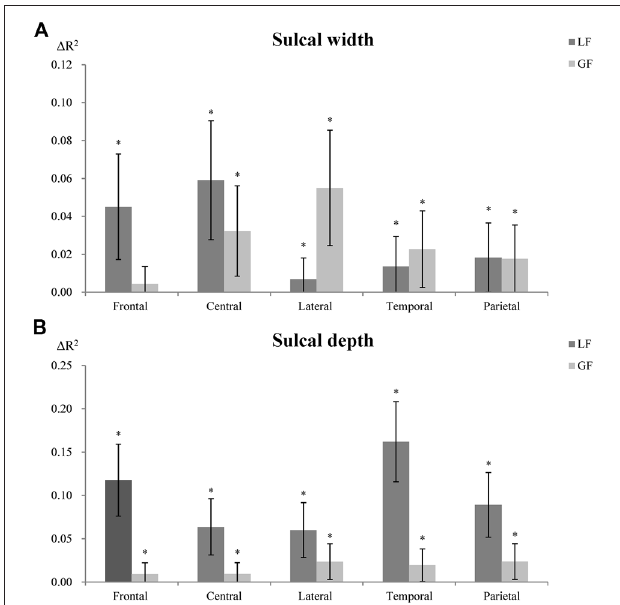
FIGURE 5 | Contribution of LF and GF to sulcal width (A) and depth (B) . Local factors (LF); global factors (GF). The R-squared changes ( ∆ R 2 ) indicate changes of explanatory power between models with and without LF or GF (proportion of variability of the sulcal measures explained by LF or GF). ∗ Indicates significant association ( p < 0.01) between LF or GF and sulcal width or depth. Error bar shows 95% confidence interval, which indicates significant differences (95% confidence interval not overlapping) between LF and GF in explaining sulcal width/depth.